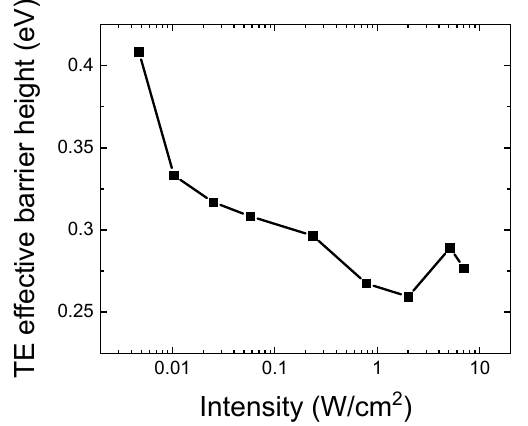
Figure 9. Estimation of the effective barrier height H from the fit of Δ J SC with Equation (10). The points at the three highest intensities are fitted neglecting the contribution of SRH recombination.